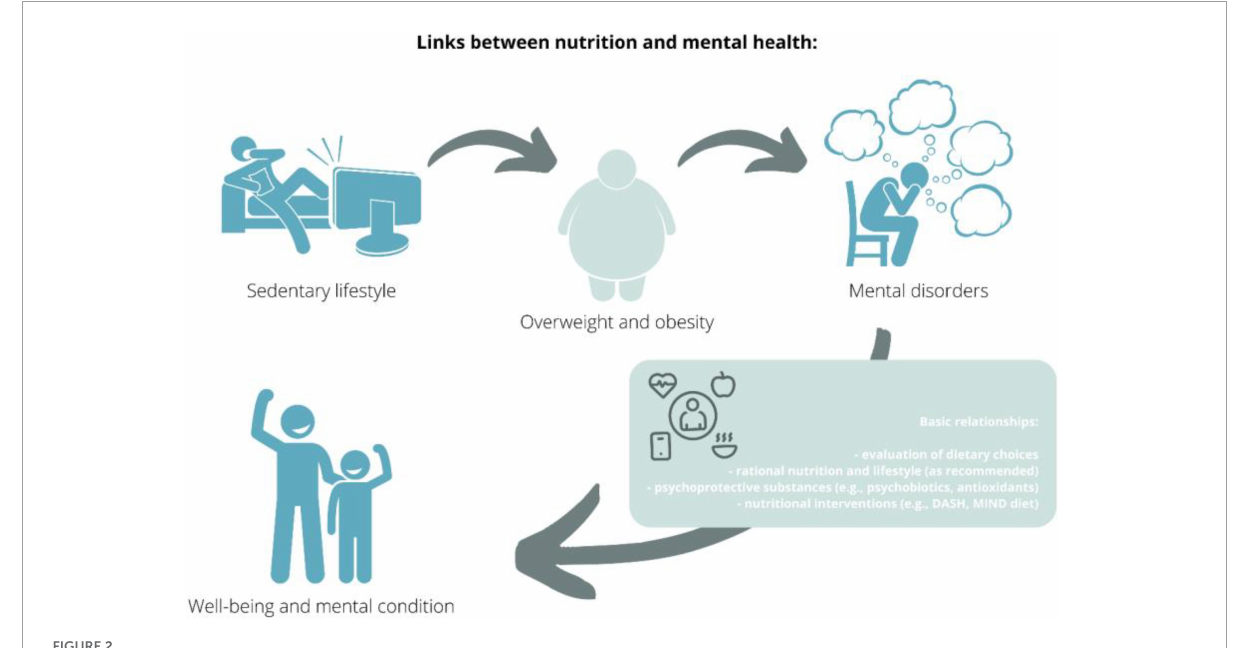
FIGURE2 Links between nutrition and mental